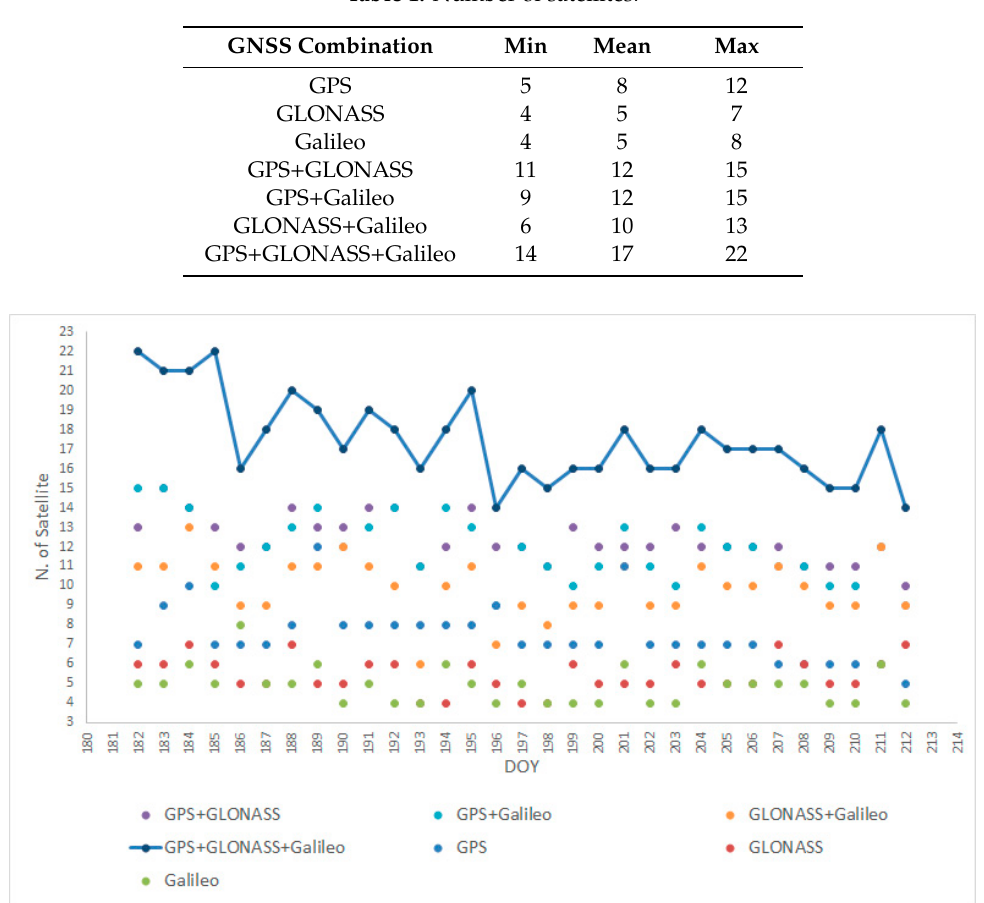
Table 1. Number of satellites.